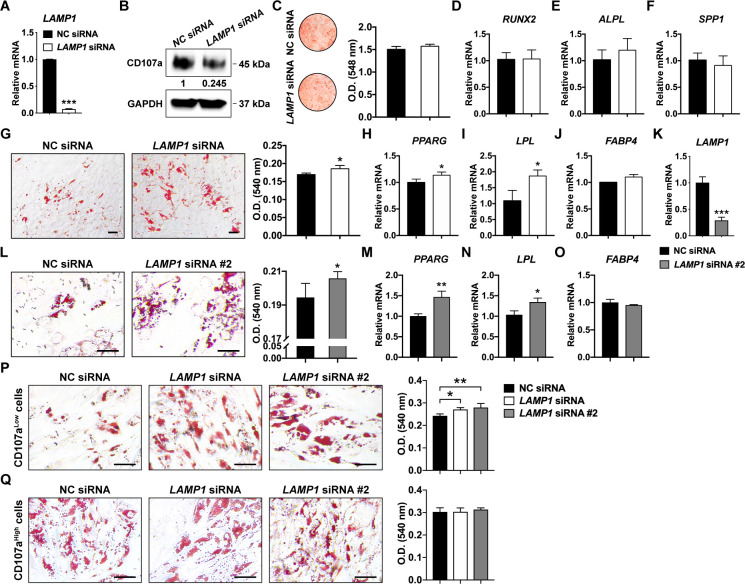
Effect of LAMP1 knockdown (encoding CD107a) on osteogenic and adipogenic differentiation in human ASCs and CD107alow/high cells.(A) Gene expression of LAMP1 as assessed by qRT-PCR after siRNA-mediated knockdown. (B) Western blotting analyses of CD107a expression in human ASCs after siRNA-mediated knockdown. (C) Alizarin red (AR) staining (left) and photometric quantification (right) at d 7 of osteogenic differentiation with or without LAMP1 siRNA. Whole well shown. (D–F) Osteogenic gene expression with or without LAMP1 siRNA assessed by qRT-PCR, including (D) Runt related transcription factor 2 (RUNX2), (E) Alkaline phosphatase (ALPL), and (F) Osteopontin (SPP1). Gene expression assessed at 7 d of osteogenic differentiation. (G) Oil red O (ORO) staining (left) and photometric quantification (right) at d 7 of adipogenic differentiation with or without LAMP1 siRNA. (H–J) Adipogenic gene expression with or without LAMP1 siRNA, including (H) Peroxisome proliferator-activated receptor-γ (PPARG), (I) Lipoprotein lipase (LPL), and (J) Fatty acid-binding protein 4 (FABP4). Gene expression assessed at 7 d of adipogenic differentiation. NC, negative control. (K) Gene expression of LAMP1 as assessed by qRT-PCR after #2 siRNA-mediated knockdown. (L) ORO staining (left) and photometric quantification (right) at d 7 of adipogenic differentiation with or without LAMP1 siRNA #2. (M–O) Adipogenic gene expression (7 d) with or without LAMP1 siRNA #2, including (M) PPARG, (N) LPL, and (O) FABP4. (P,Q) ORO staining (left) and photometric quantification (right) at d 7 of adipogenic differentiation with or without LAMP1 siRNA in (P) CD107alow and (Q) CD107ahigh cells. Black scale bar: 50 μm. Data repeated in experimental triplicate wells. *p<0.05; **p<0.01; ***p<0.001. Statistical analysis was performed using a two-tailed Student t-test or a one-way ANOVA followed by Tukey’s post hoc test.